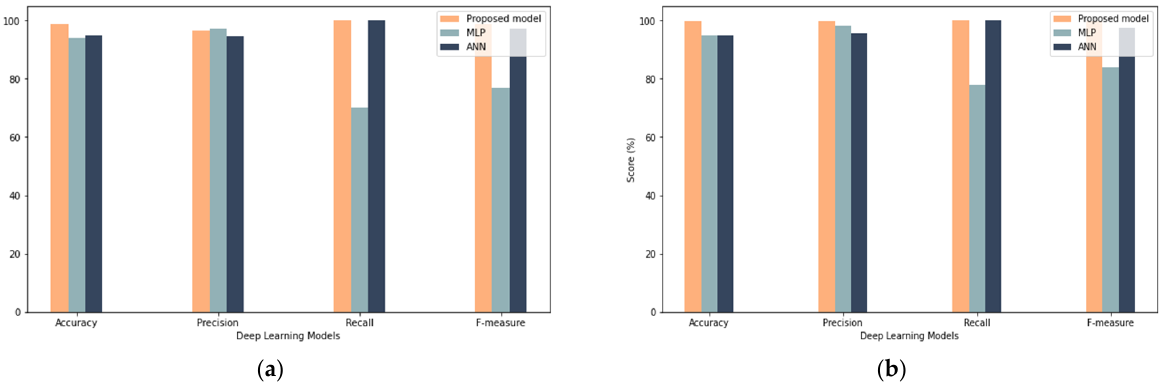
Figure 13. Comparison with deep learning results: ( a ) results for the 50% sample size with 50 itera- tions, ( b ) results for the 50% sample size with 100 iterations.